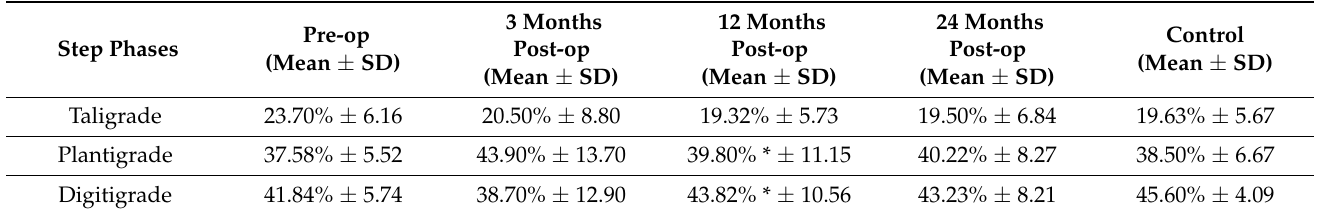
Table 1. Pedobarography data. The percentage of each step phase for patients at four endopoints and for controls are displayed. * indicates p < 0.05 for 12 months post-op vs. 3 months